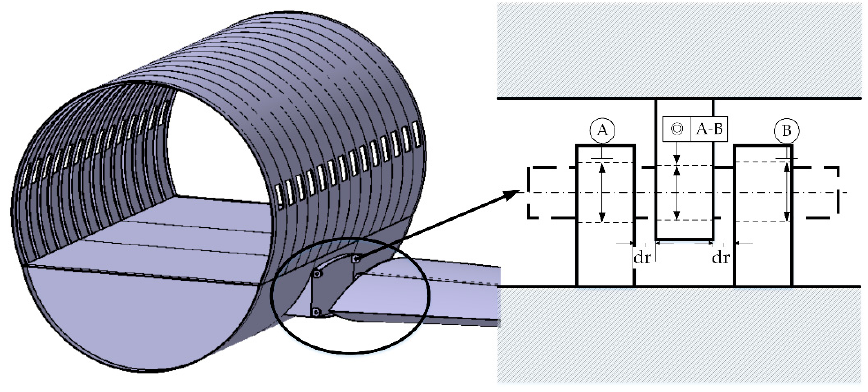
Figure 3. Wing-fuselage assembly.